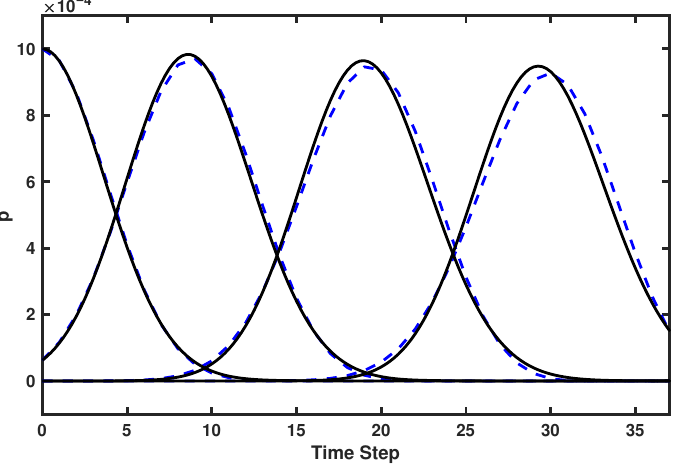
∆ x 2 ∆ t ) with σ = 0.1